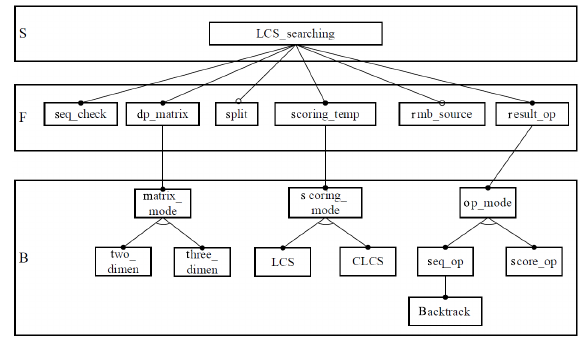
Fig. 4 LCS domain feature